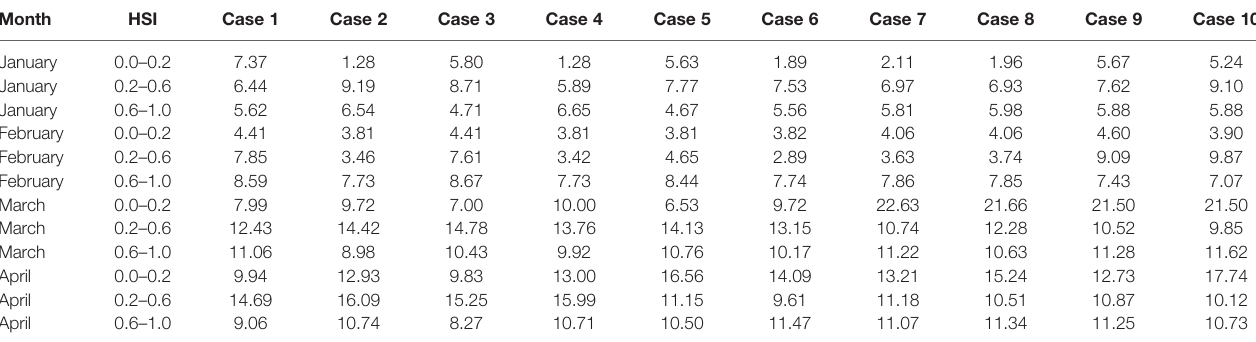
TABLE 4 | CPUE under different HSI class interval sourced from different weighting model during 2013 – 2016.